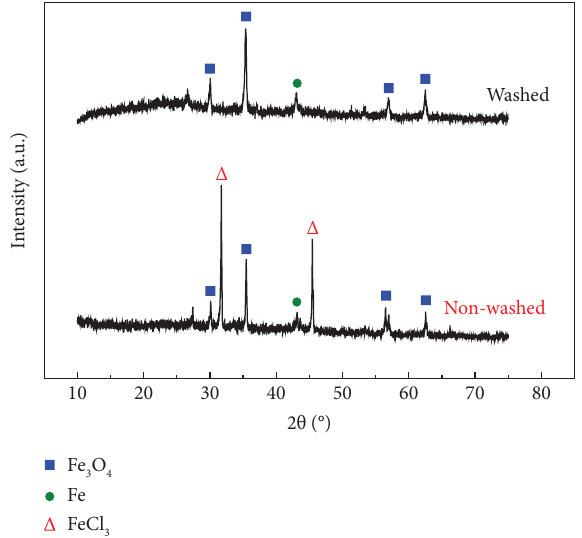
Figure 1: XRD patterns of nonwashed and washed MPC-R0.2- 2.0 h samples.